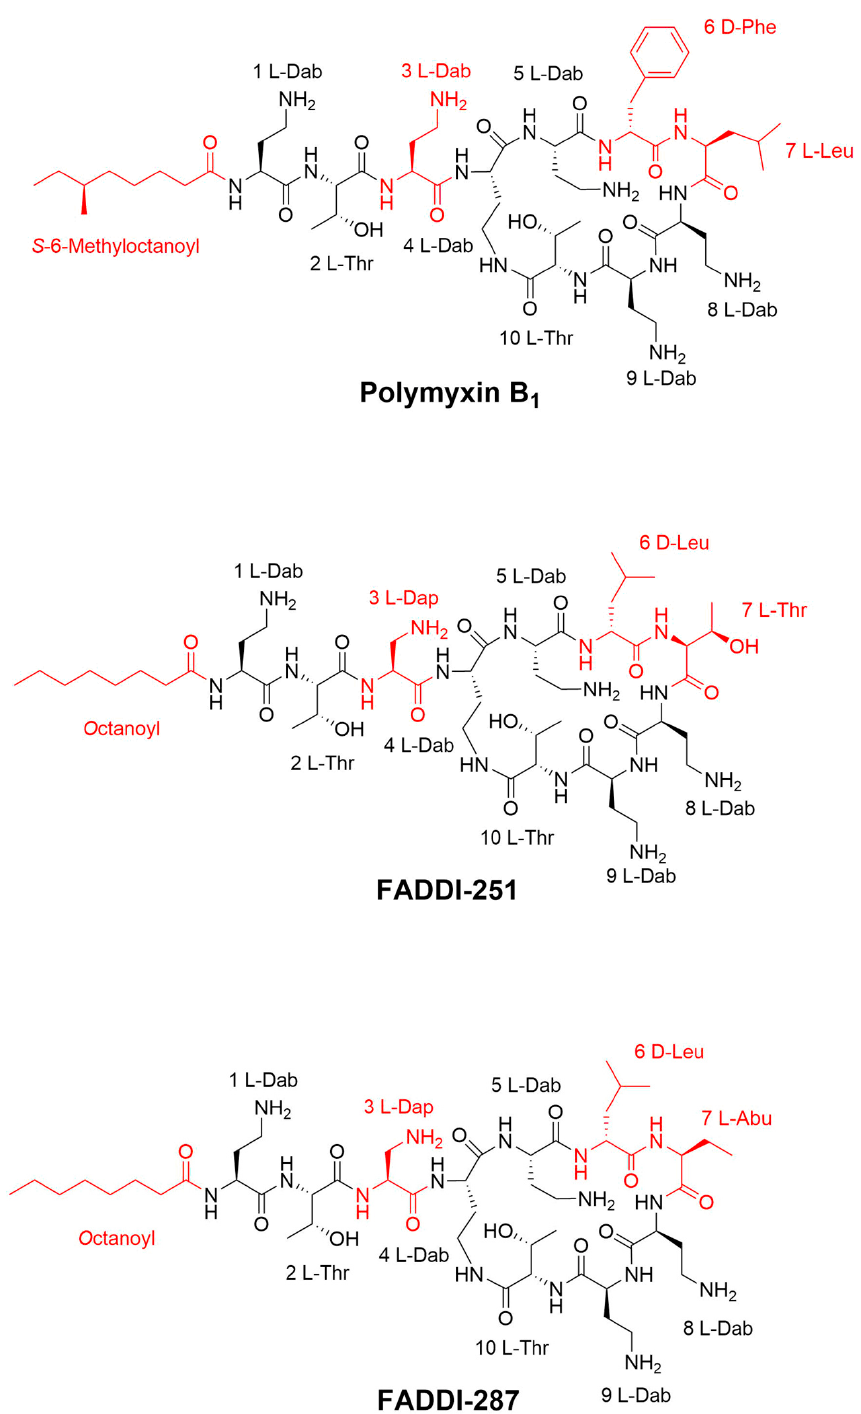
Figure 1. Chemical structures of polymyxin B 1 , FADDI-251 and FADDI-287.